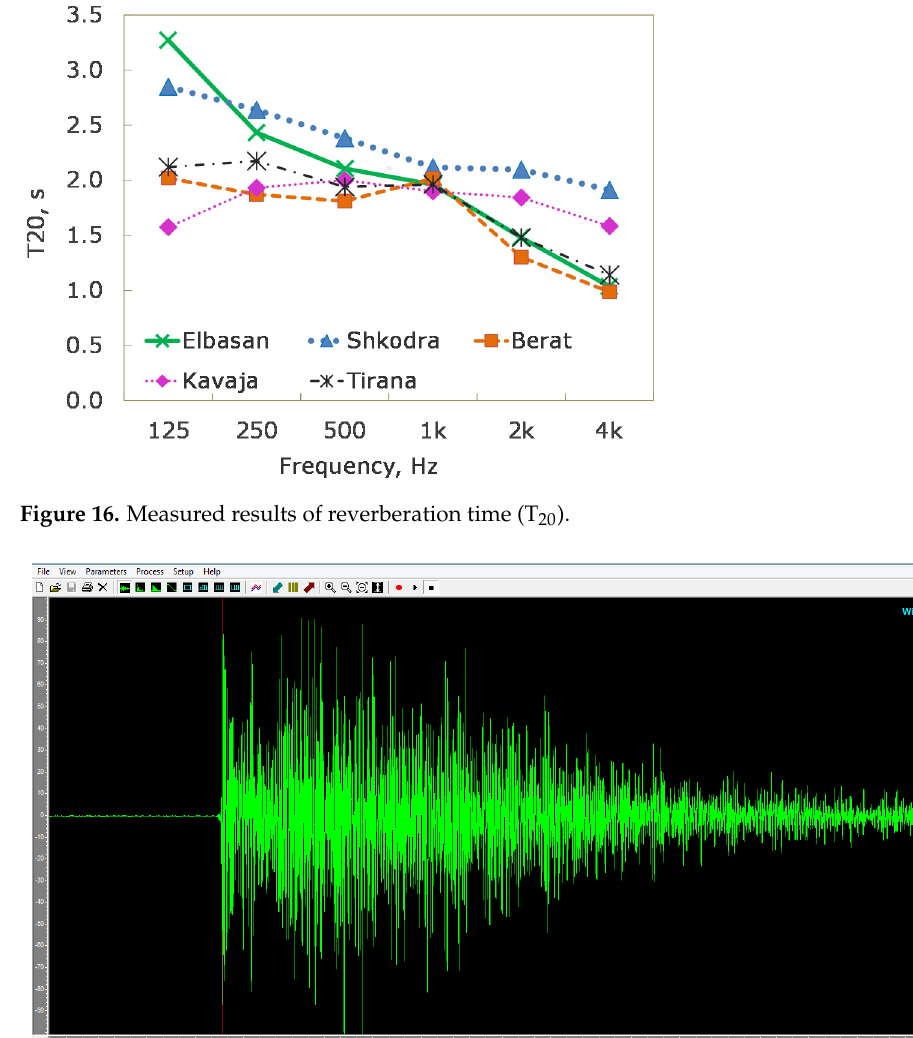
Figure 16. Measured results of reverberation time (T 20 ).